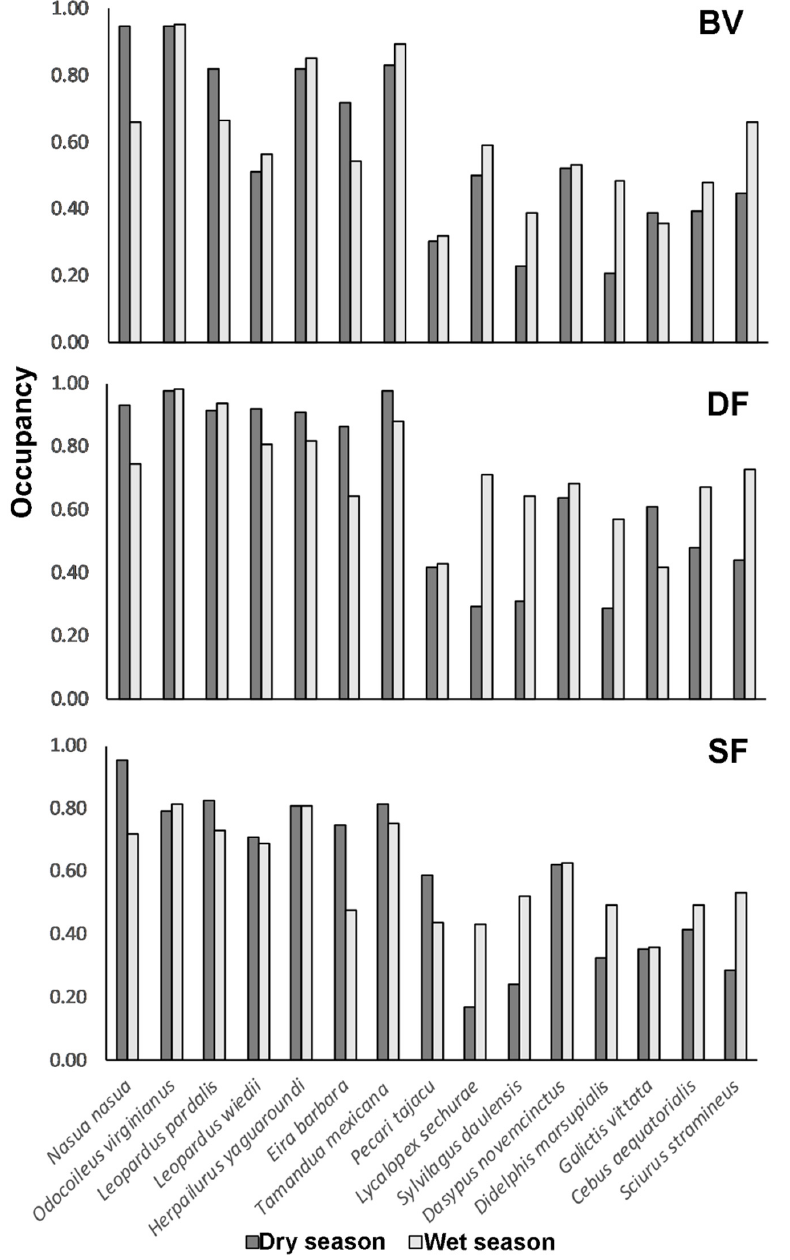
Figure 5. Comparison of the mean occupancy estimates per species per season in the three sampling